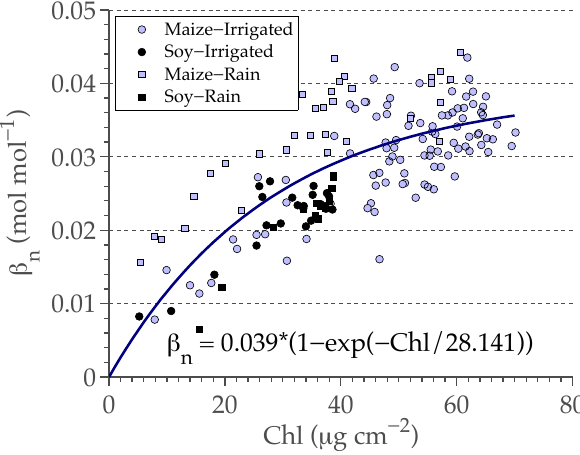
755 756 757 Figure 4. Functional relationship derived between Chl and β n for Fig. 4. Functional relationship derived between Chl and 𝛽 ! for irrigated and rain-fed fields of 758 irrigated and rain-fed fields of maize and maize and soybean. 759